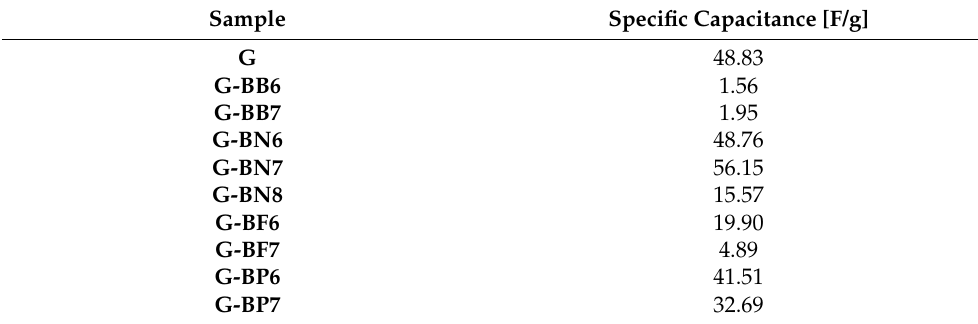
Table 1. Specific capacitance of obtained electrode materials at the current density of 1